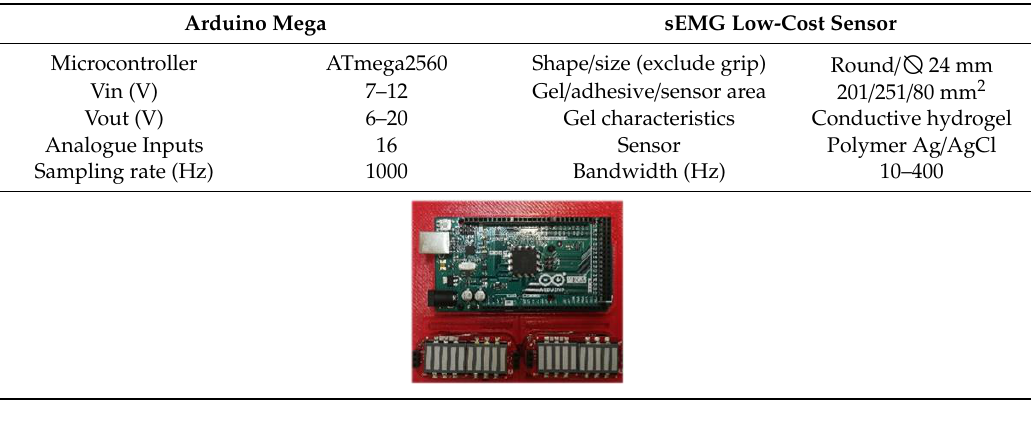
Table 1. Technical information of the sEMG device.